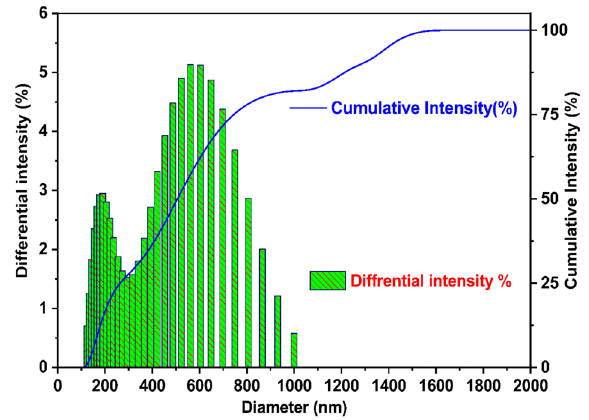
Figure 7. Particle size distribution curve of WAS-BC adsorbent.